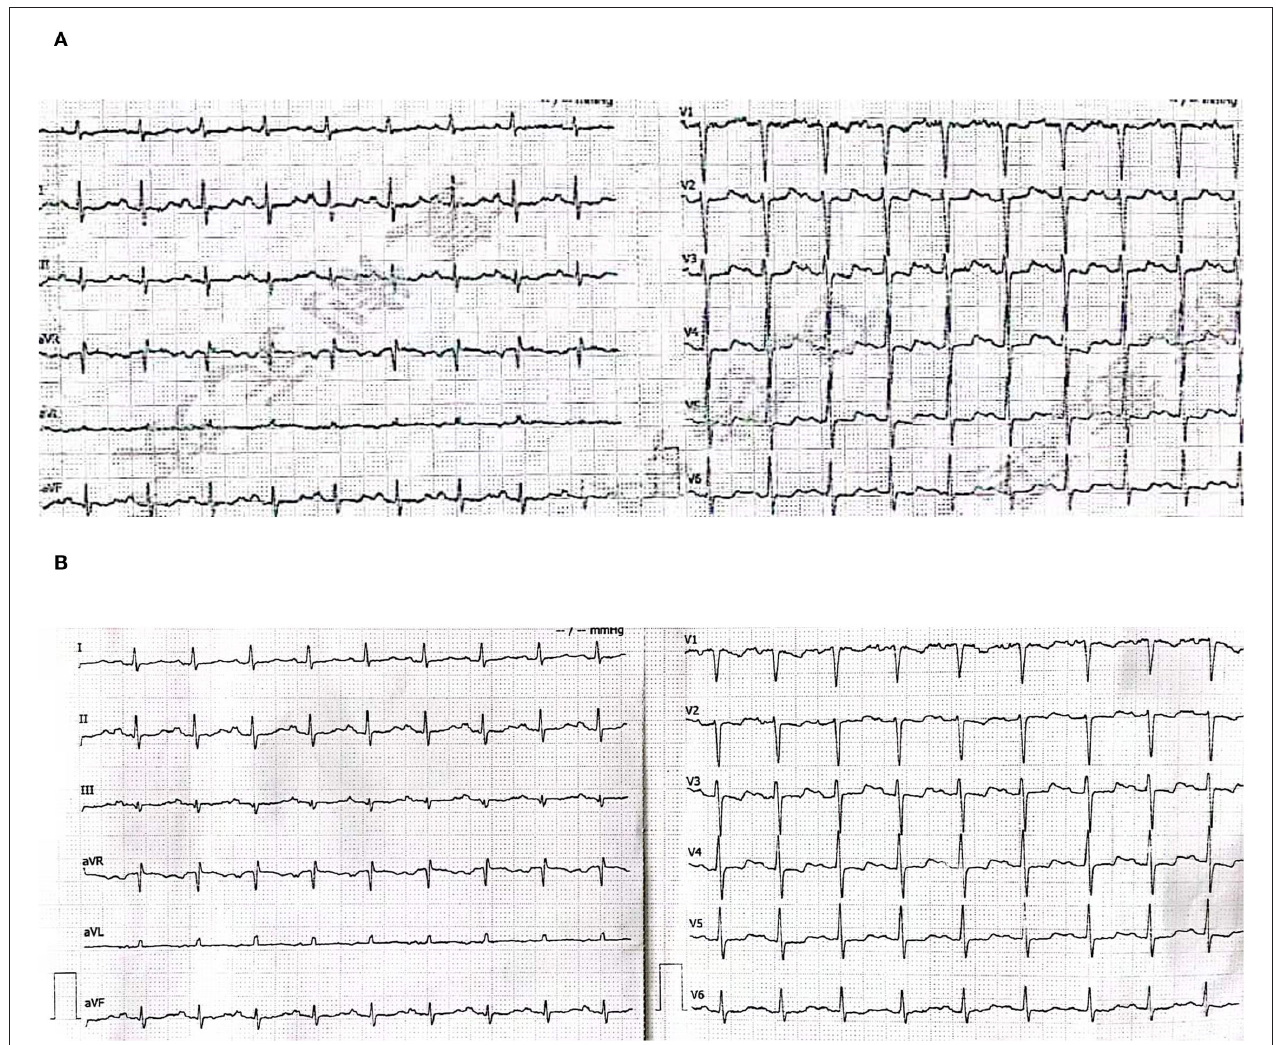
FIGURE 2 | (A) Electrocardiogram for the first (emergency department). Sinus tachycardia, mild depression of the ST segment in V3 ∼ V5, T wave inversion in lead V1, and bidirectional in lead V4. (B) Electrocardiogram for the second time (the ward of the department of cardiovascular